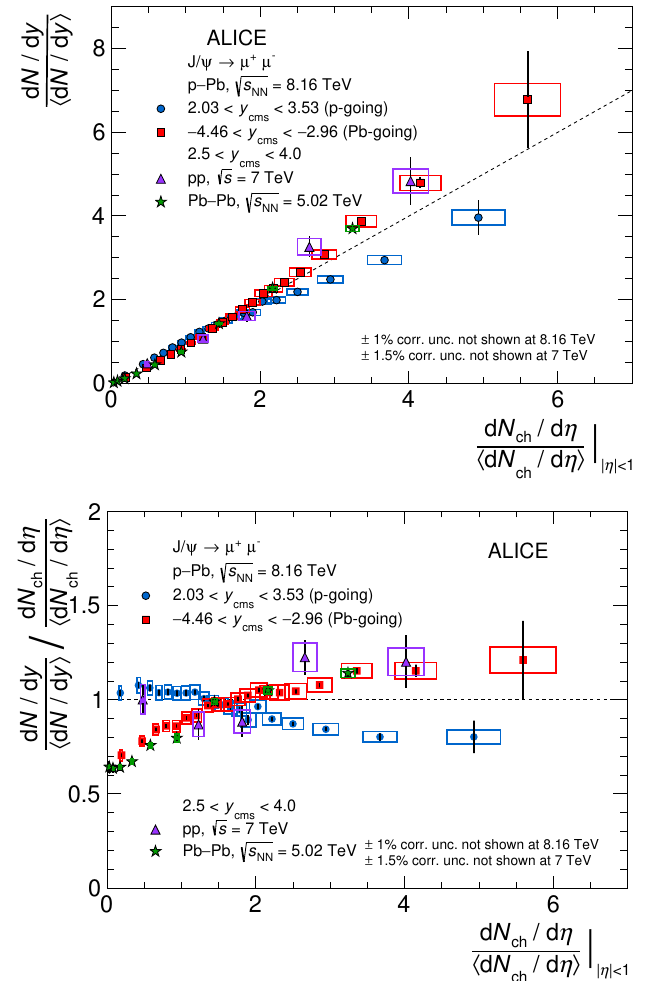
Figure 8 . Top: normalized yield of inclusive J = as a function of the normalized charged-particle pseudorapidity density, measured at midrapidity, in various collision systems. Bottom: ratio of the normalized yields to the corresponding normalized charged-particle pseudorapidity density. The pp results are normalized to INEL collisions [29], whereas p-Pb ones refer to the NSD event class; all for p T > 0. The Pb-Pb data points include J = with 0 : 3 < p T < 12 GeV =c to reduce the low- p T contribution from photoproduction, which is signi(cid:12)cant only in more peripheral collisions [62, 64, 65]. The vertical bars represent the statistical uncertainties, the boxes the systematic ones. The dashed line indicates the one-to-one correlation, to guide the